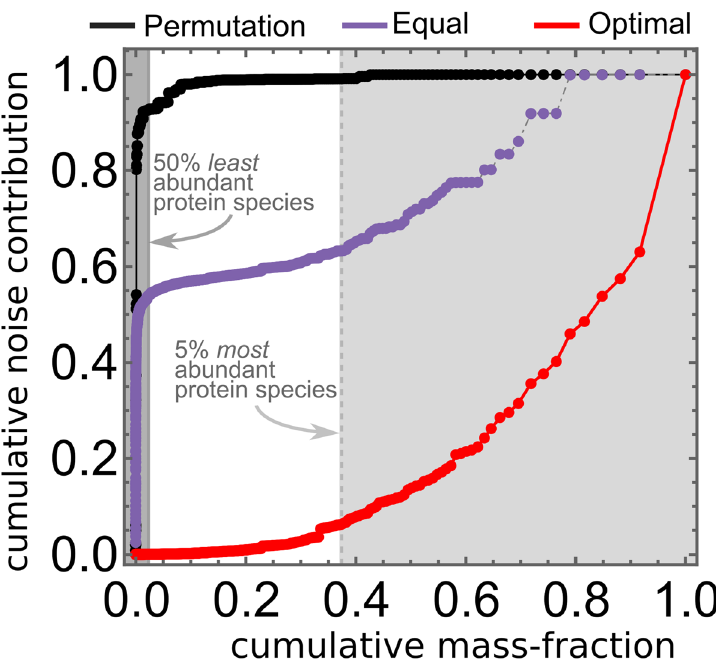
Fig 1. Cumulative noise contribution as a function of cumulative mass fraction, both calculated from protein abundances and noise levels measured in E. coli [16]. Protein species were ordered by their mass fraction ϕ cumulative mass fractions and noise contributions subsequently calculated as are either set by Eq 5 (red dots), all equal (purple dots), or a random permutation of the optimal GCCs (black